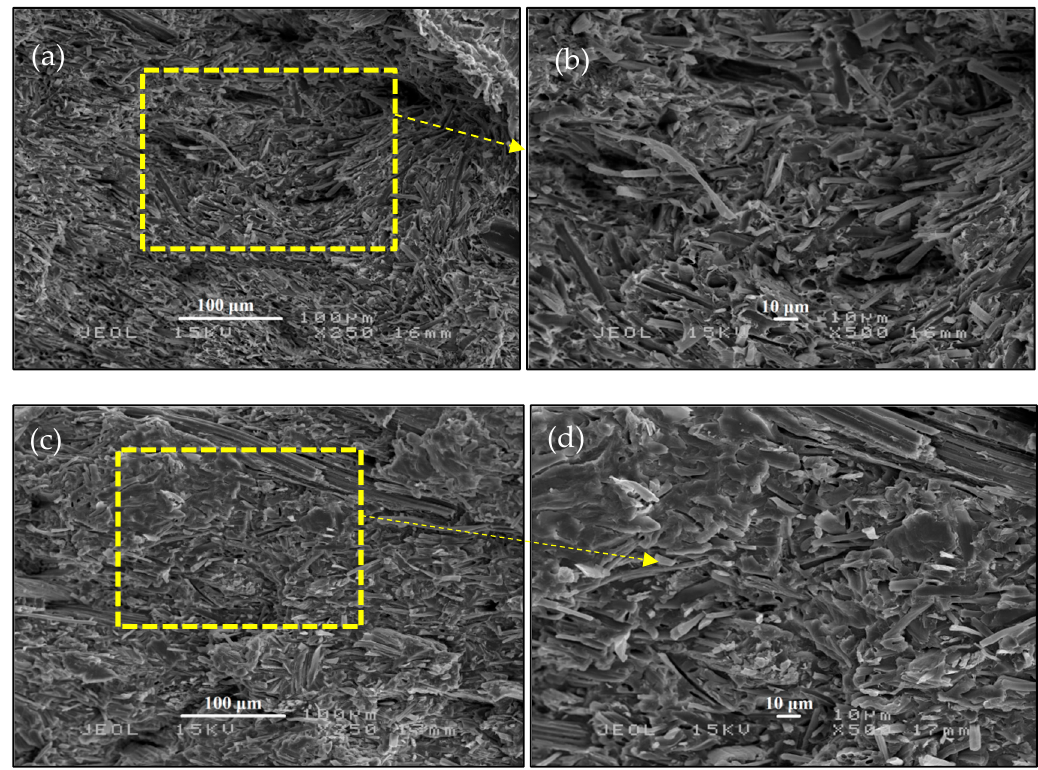
Figure 4. SEM micrographs of PALF/PLA ( a ) 250x, ( b ) 500x; and SHS-PALF/PLA ( c ) 250x, ( d ) 500x biocomposites.